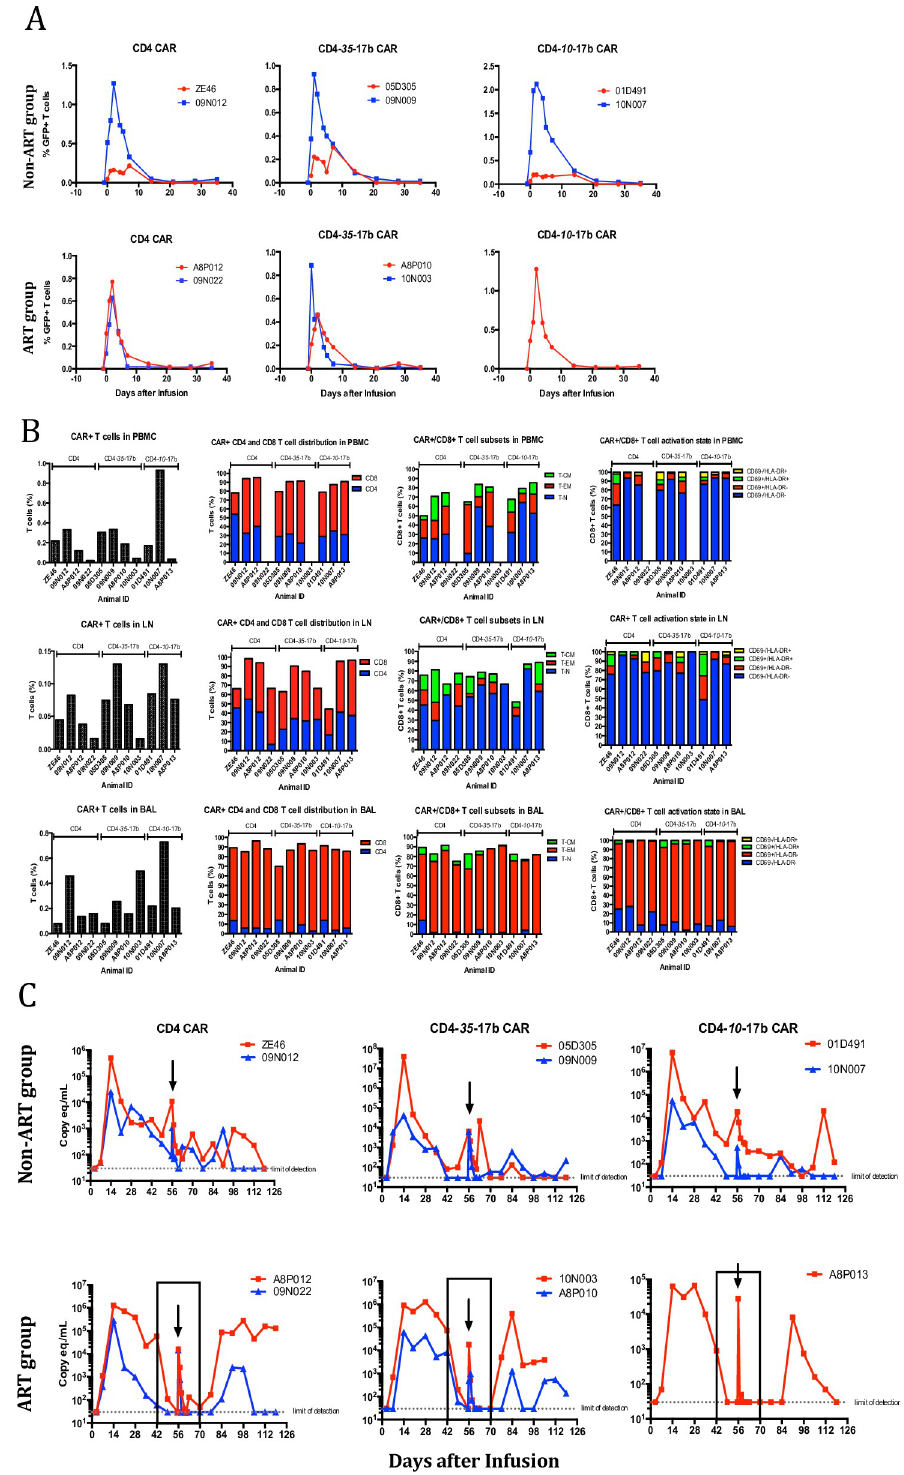
Fig 2. CAR T cell therapy on anti-SHIV-infected animals. (A) Adoptively transferred CAR-modified T cells were quantified within PBMC via flow-cytometry through the co-expressing fluorescent marker, eGFP, within non-ART treated animals (top row) and ART treated animals (bottom row). CAR+ T cells expand in PBMC within the first two days of adoptive transfer, but rapidly decline and become undetectable after 3 weeks. (B). CAR+ T cells were quantified